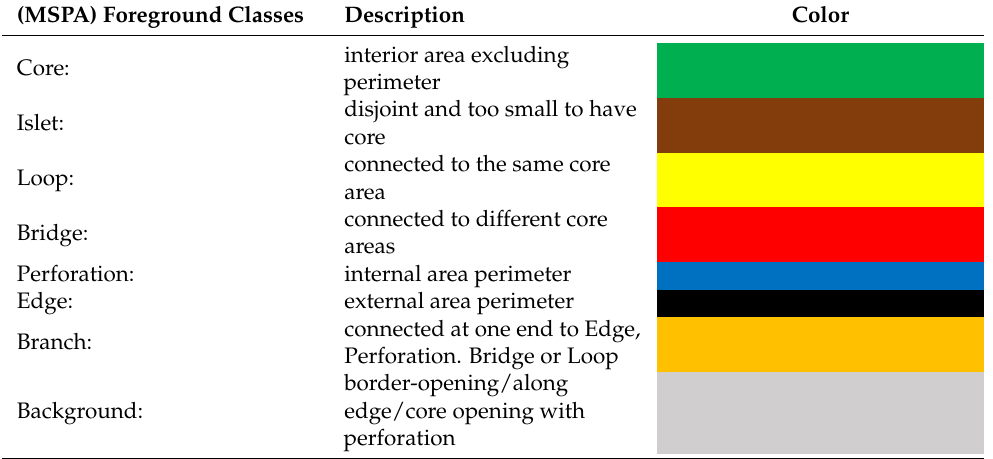
Table 4. Foreground classes for morphological spatial pattern